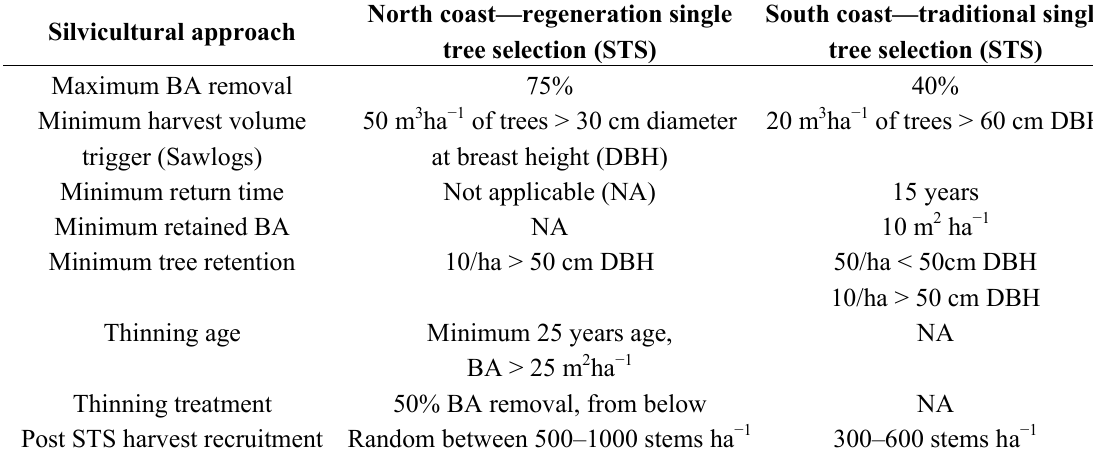
Table 2. Silvicultural approaches adopted in FRAMES for harvesting